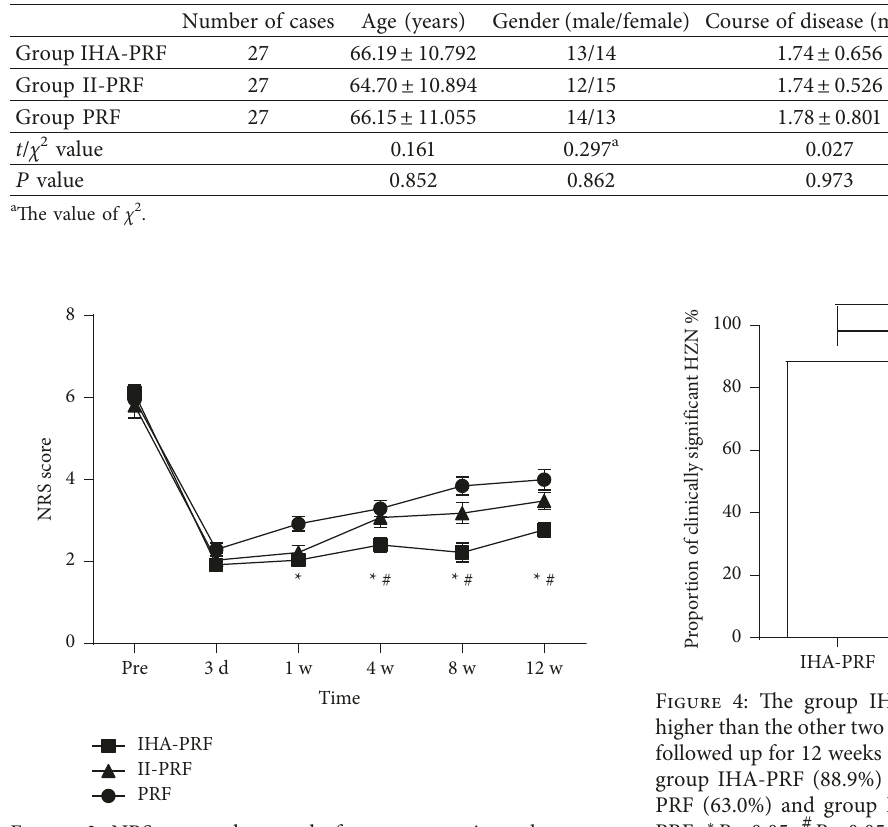
Figure 3: NRS scores decreased after treatment in each group. Compared with before treatment, NRS scores of the three groups decreased at each time point after treatment. NRS scores of patients in group IHA-PRF significantly decreased at 4, 8, and 12 weeks after the treatment course. NRS scores of patients in group IHA- PRF decreased at 1, 4, 8, and 12 weeks after the treatment course.